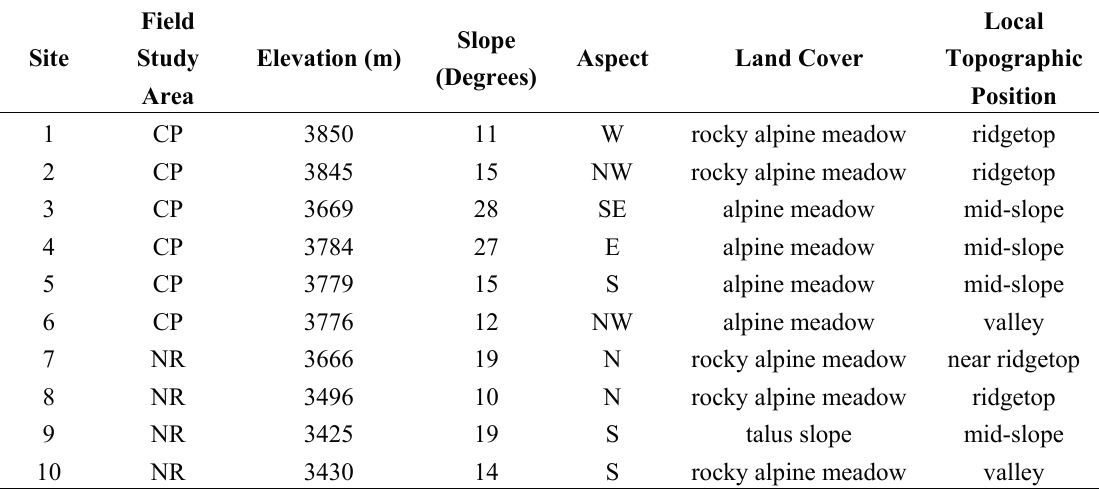
Table 4. Study area location and site characteristics for 60 × 60 m grid cell footprints where in situ monitoring was conducted. CP indicates Cinnamon Pass, while NR indicates Niwot Ridge.